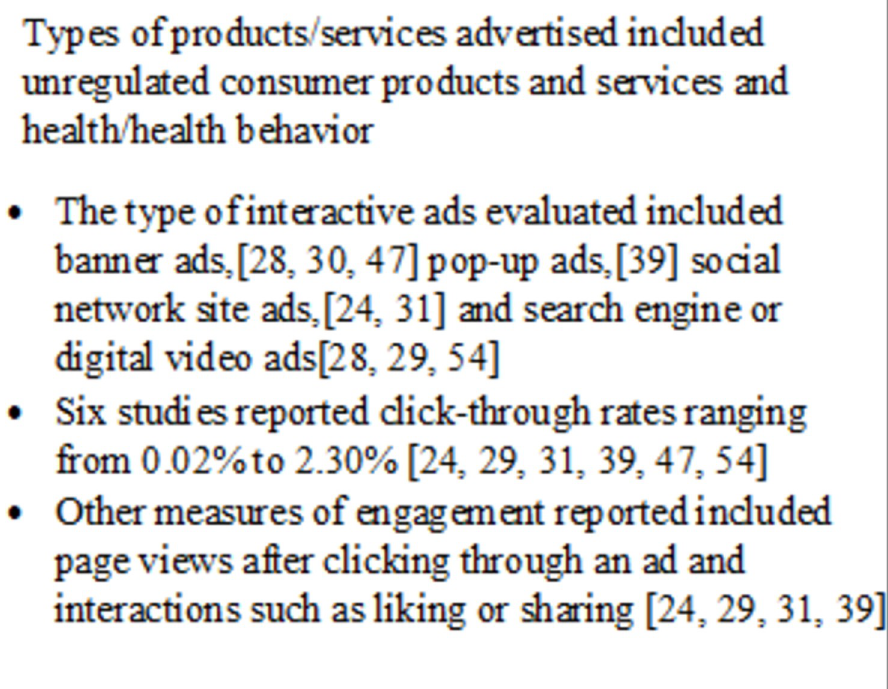
Fig 3. Summary of findings from 8 studies addressing research question